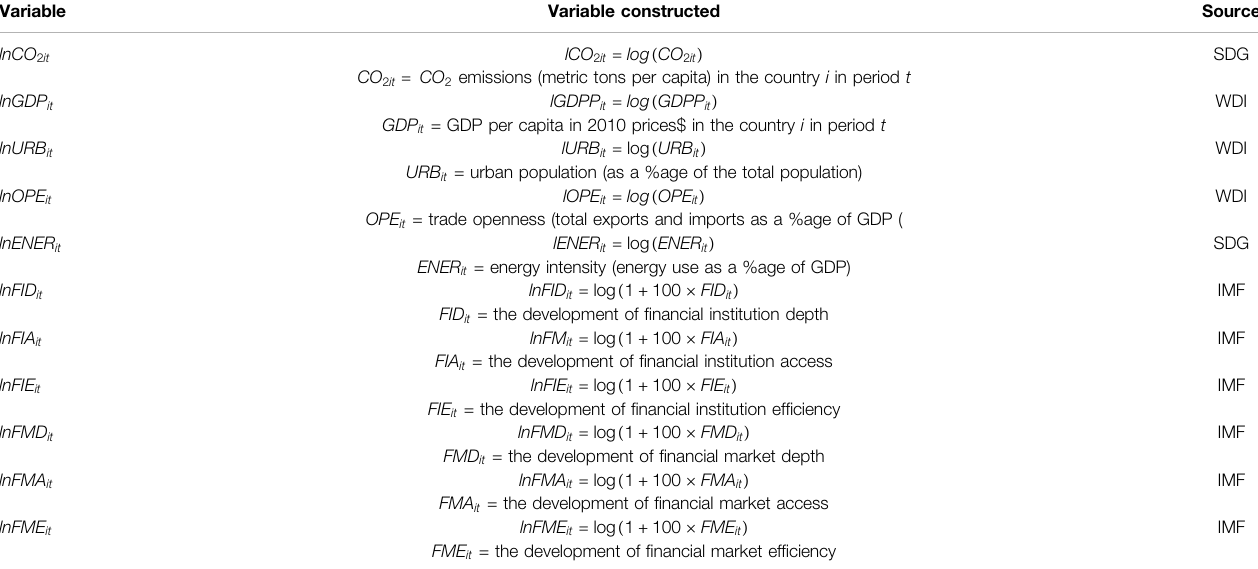
TABLE 1 | Creations of new variables.